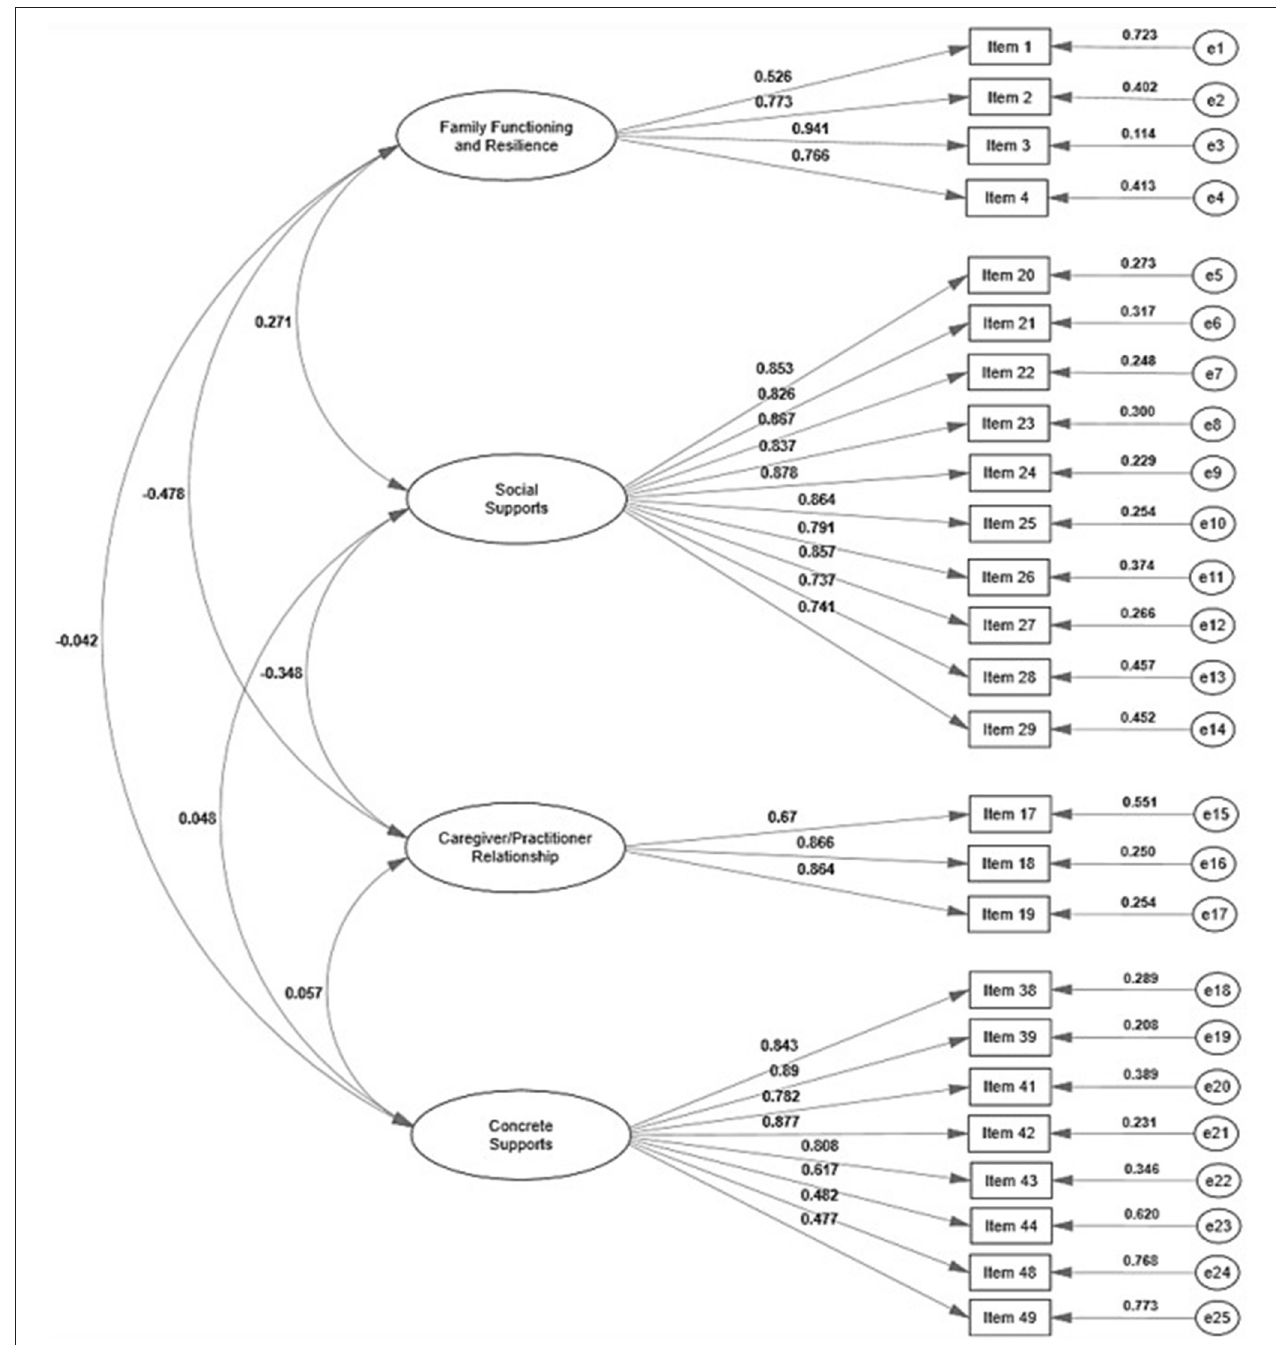
FIGURE 2 | Modified correlated 4-factor model of PFS-T. The estimates of the presented factor loadings, variances, and covariances are